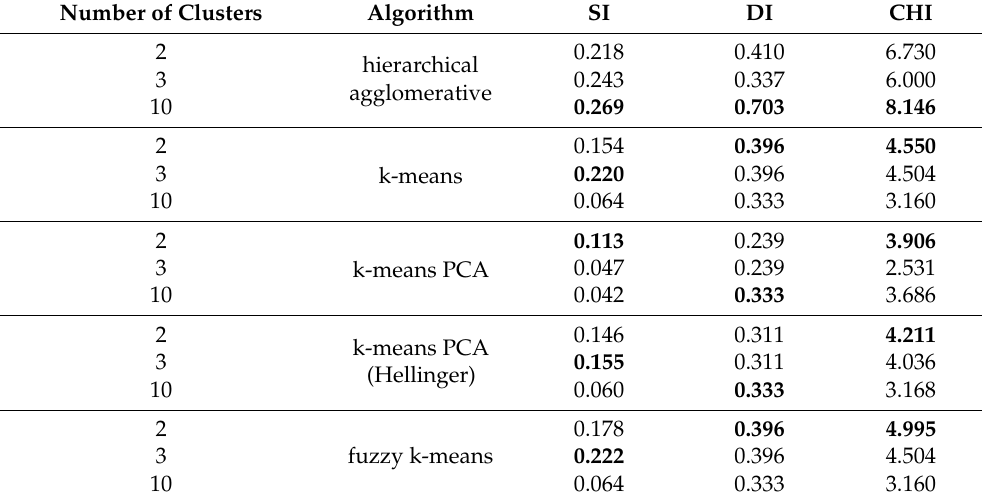
Table 3. Internal cluster validation metrics for different algorithms and number of clusters. Values in bold indicate the per algorithm optimal number of clusters. SI is the silhouette index, DI is the Dunn index and CHI is the Calinski–Harabasz